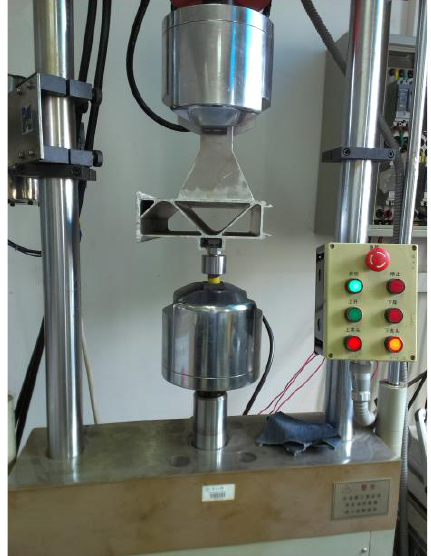
Figure 9. Test structure component being clamped on the tester.